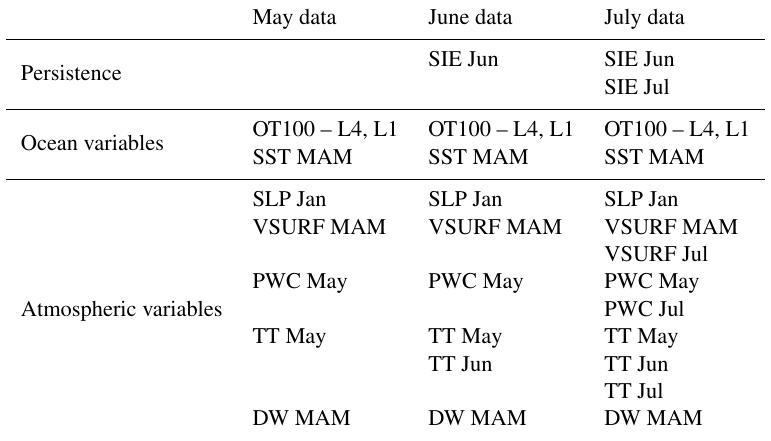
Table 5. Variables retained for the September East Siberian sea (ESS) ice extent forecast (black boxes in Figs. 5–7). Seasonal averages are indicated as spring MAM (March, April, May); single months are abbreviated with the first three letters of the